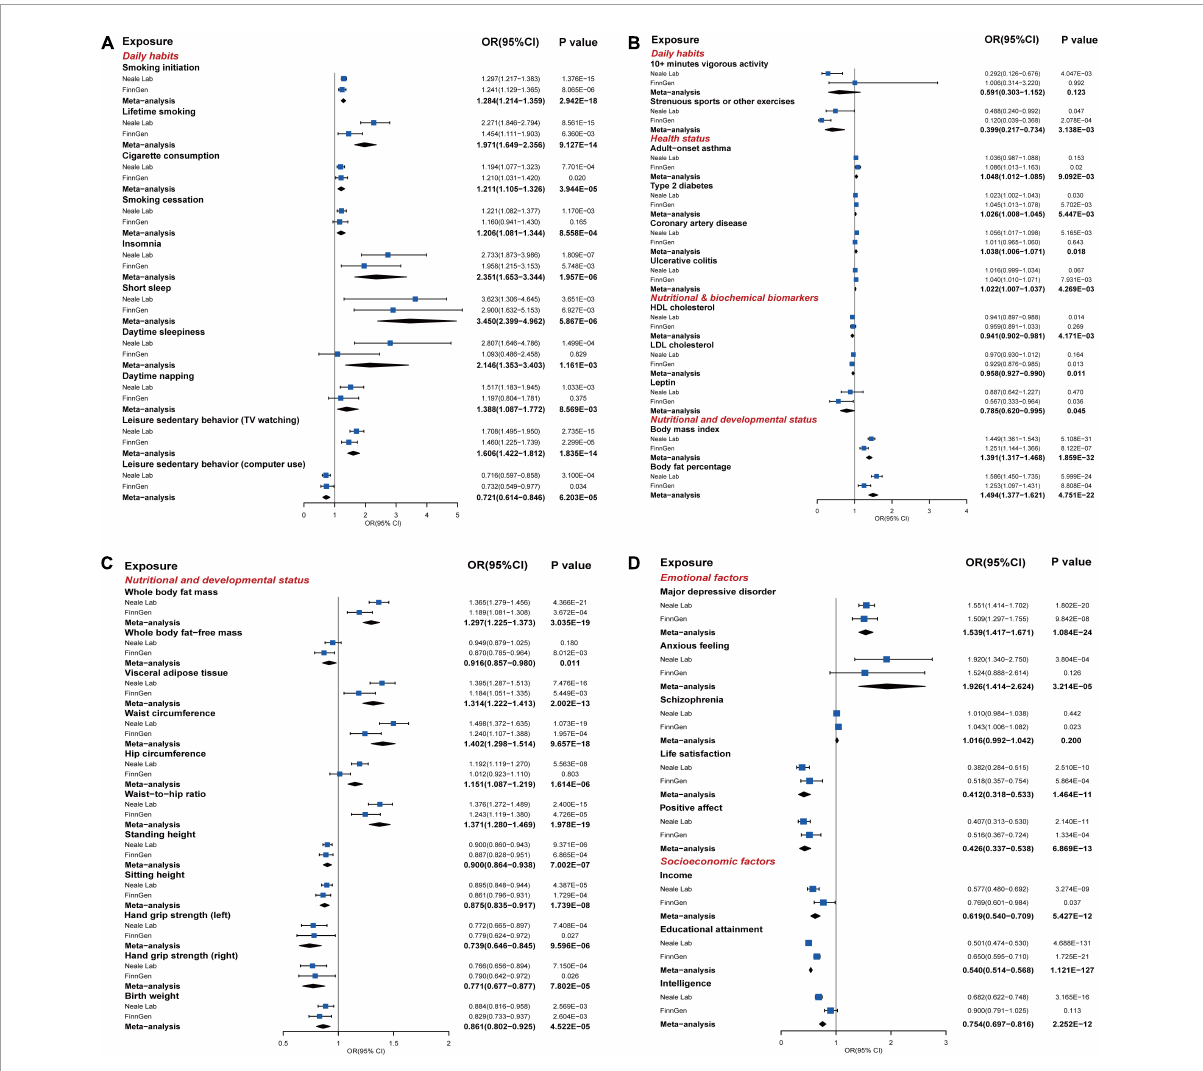
FIGURE4 The statistically significant results of MR analysis in the discovery phase or replication phase and meta-analysis ( P ≤ 0.05). (A–D) The forest plots graphically illustrated the aggregated results for 40 exposures that have statistically significant causal associations with the risk of GORD based on the IVW method in the discovery phase, replication phase, or meta-analysis, where “Neale Lab,” “FinnGen,” and “Meta-analysis,” respectively, denoted the MR results in the discovery phase, replication phase, and meta-analysis. The causal effects were represented as odds ratios (ORs) with IVW method (blue box). The MR results of the discovery phase, replication phase, and meta-analysis with IVW method, weighted median method, MR-Egger method, and MR-PRESSO method were summarized in Supplementary Tables 4 – 6 in